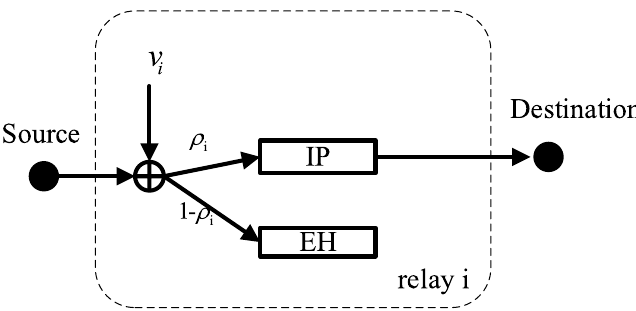
Fig. 3 The DF relaying mode. It is our proposed PS-based energy-harvesting relaying scheme in DF